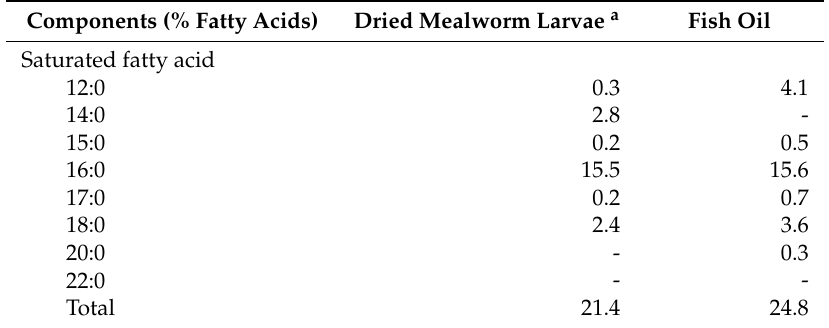
Table 4. Fatty acid compositions in mealworm larvae and fish oil for the experimental diets. Components (% Fatty